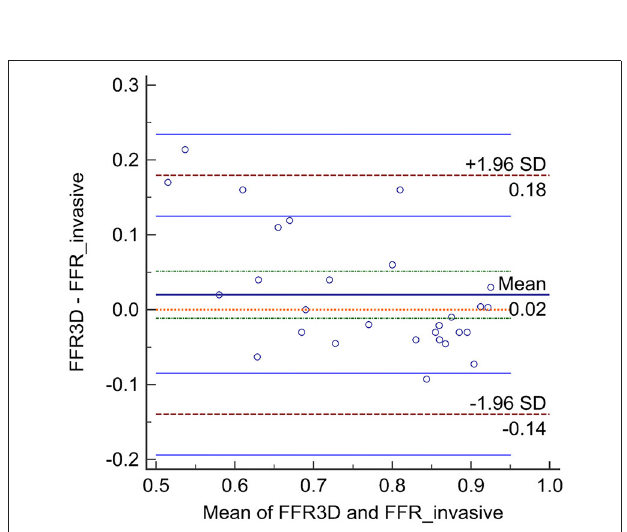
FIGURE 4 | Bland-Altman analysis between FFR 3D and invasive FFR.